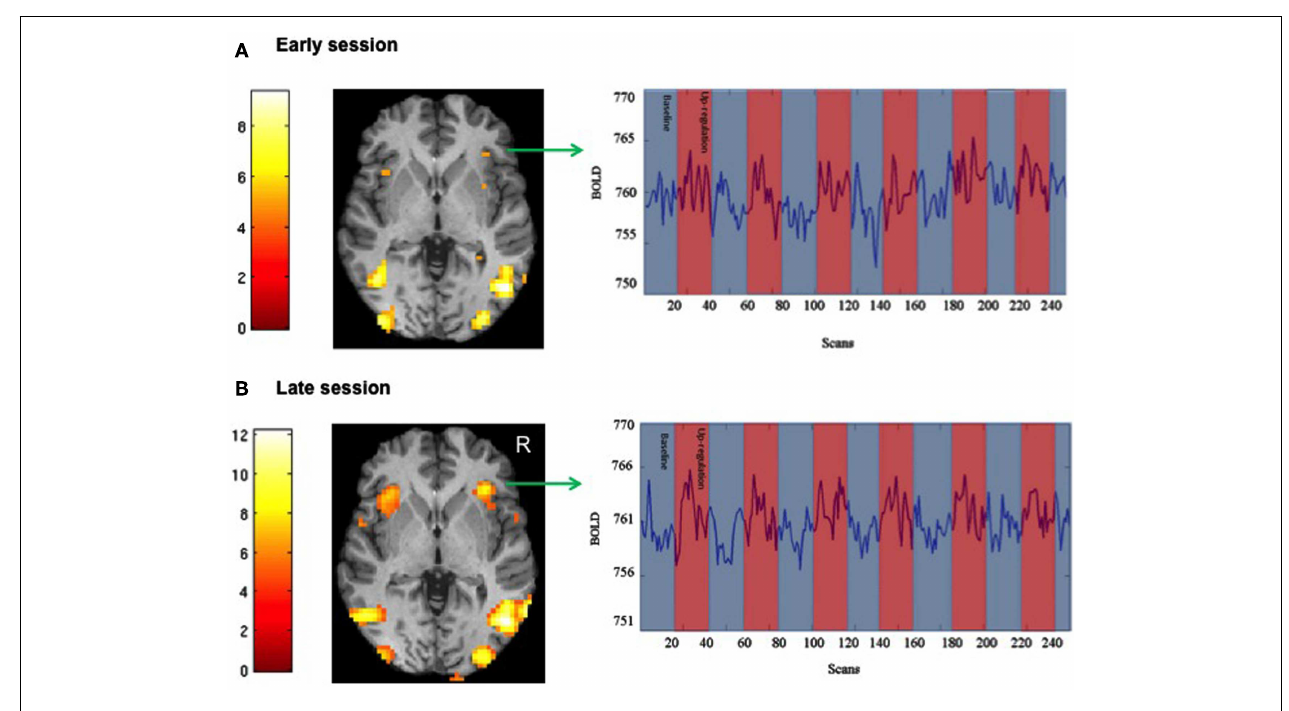
for right anterior insula are also shown in the respective sessions (blue and red bars represent the experimental conditions baseline and self-regulation, respectively) adapted with permission from Ruiz et al.